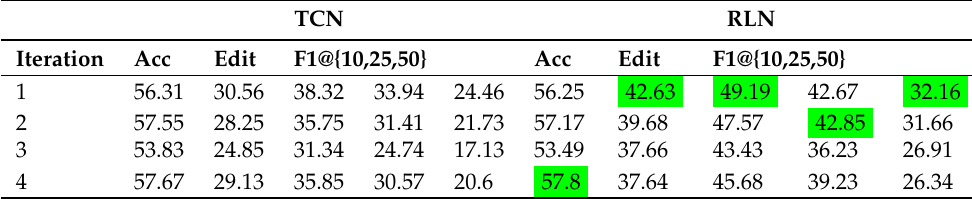
Table 14. RL-SSI in the Scrambled Egg